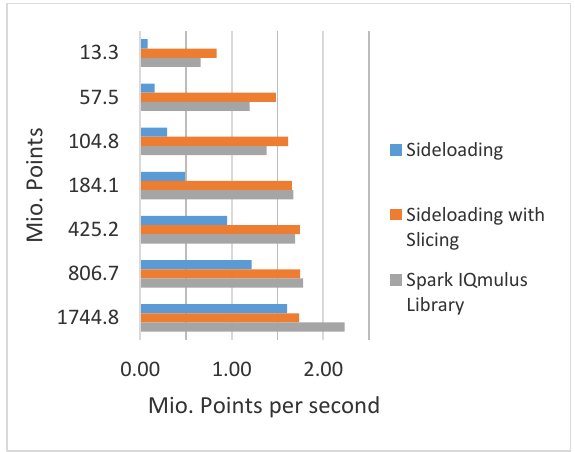
Figure 10: Throughput of a five node cluster with different point cloud